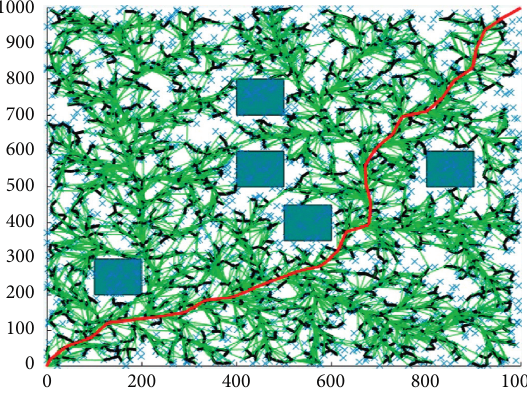
Figure 11: The path planned by NPQ-RRT ∗